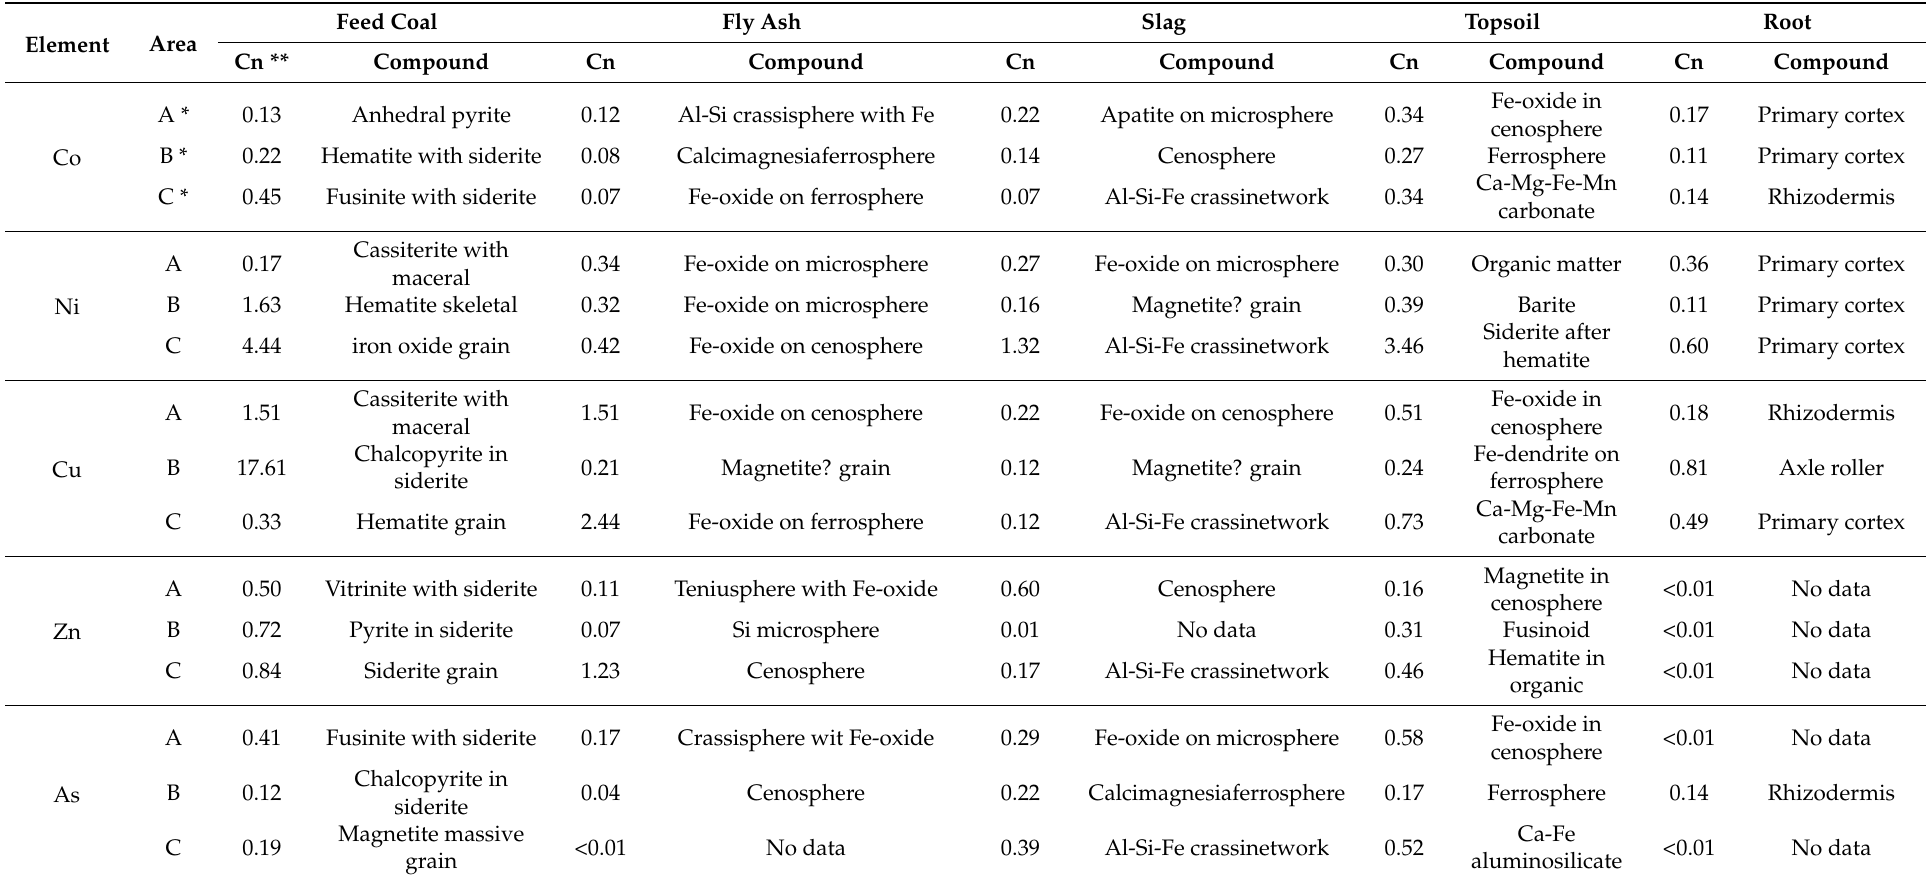
Table 3. Maximum content (wt %) of element in feed coal, fly ash, slag, topsoil, and undergrowth roots from power stations and in tested areas obtained by the scanning electron microscope (SEM/EDS)